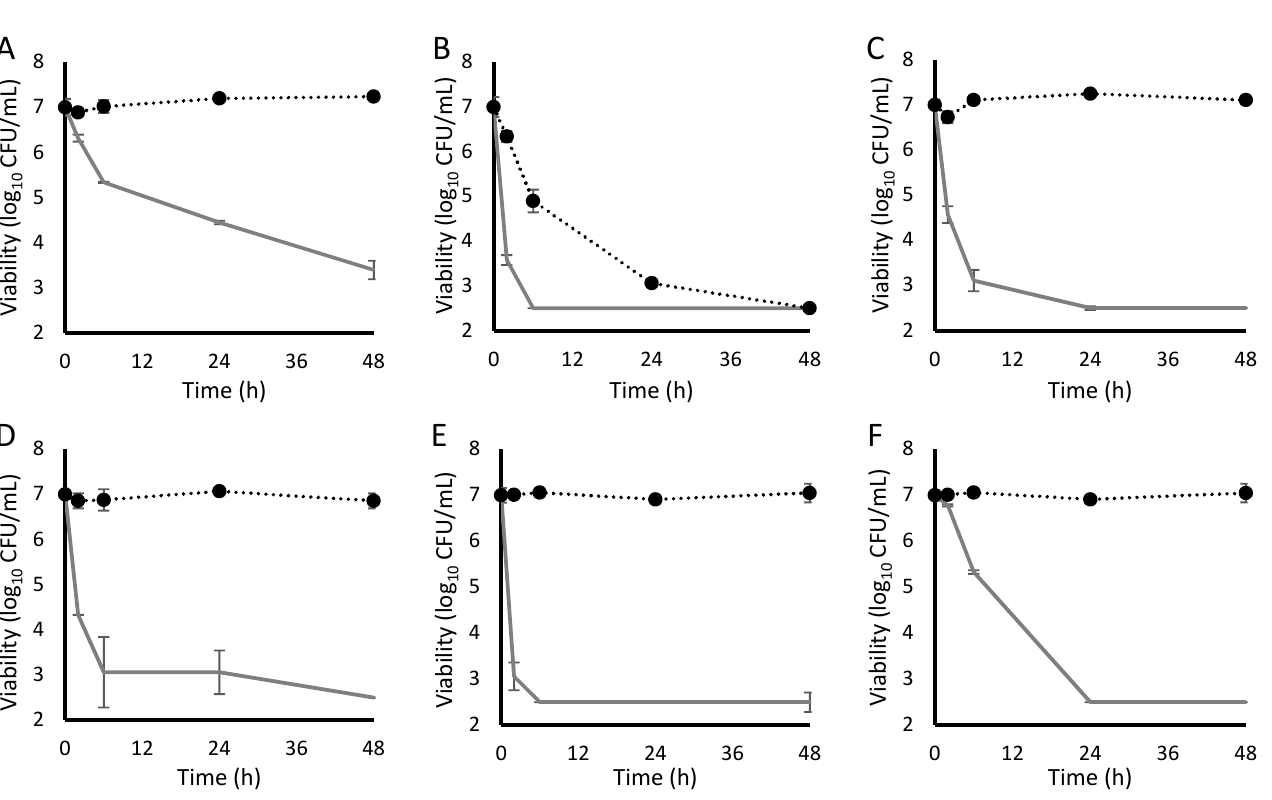
Figure 1. Activity of study antibiotics against induced-tolerant staphylococci determined in Mueller–Hinton broth. ( A ) ceftaroline; ( B ) daptomycin; ( C ) gentamicin; ( D ) levofloxacin; ( E ) oritavancin; and ( F ) vancomycin. Dotted line with black points, nutritional tolerance; dashed line with gray points, oxidative tolerance; solid line with white points, competitive tolerance; and gray line without points, no tolerance induction.